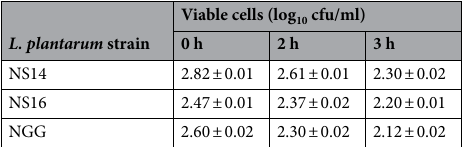
Table 4. Viable cells (log 10 cfu/ml) of L. plantarum strains in simulated gastric juice. The mean of three values ± SD are presented.